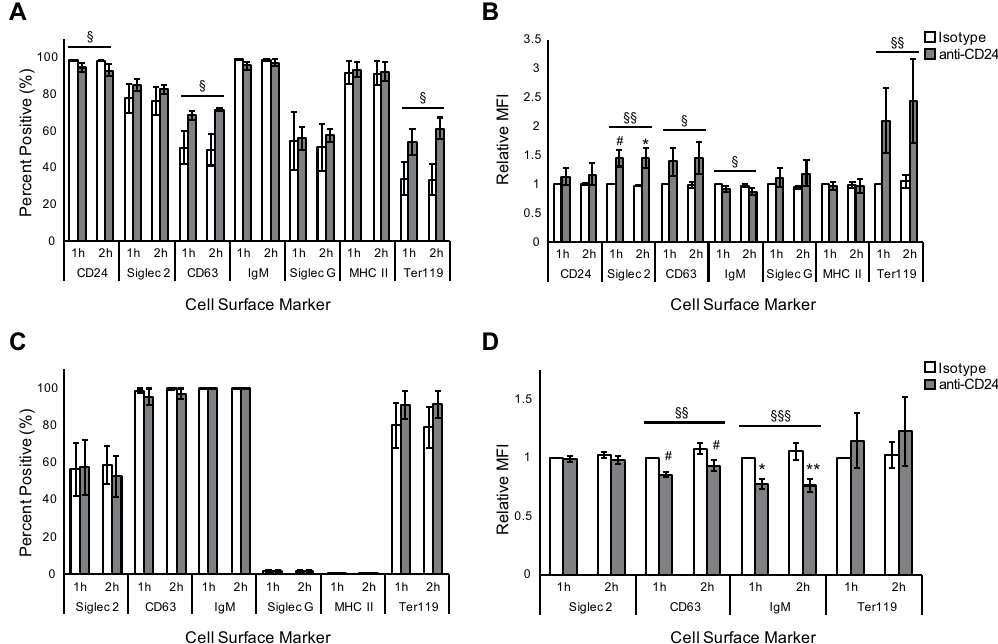
Figure 5. CD24 stimulation induces the formation of a unique B cell MV surface phenotype that does not reflect the cells from which they are released. Cells ( A , B ) and MVs ( C , D ) were analyzed for their expression of the indicated cell surface markers. Data are shown as mean ± SEM at 1 h or 2 h stimulation with either isotype or anti-CD24 Ab. n = 3–4. Cells or CD24-bearing MVs bound to beads were assessed for the percentage of ( A ) cells or ( C ) MVs positive for the individual markers, and (B/D) their relative mean fluorescent intensities (MFI). Significant differences were assessed by two-way ANOVA followed by Tukey post-hoc, if significant. Main effect of stimulation: § P < 0.05, §§ P < 0.01. Significant changes compared to time-matched control: # P < 0.1, * P < 0.05, ** P < 0.01. Non-statistically significant changes have no